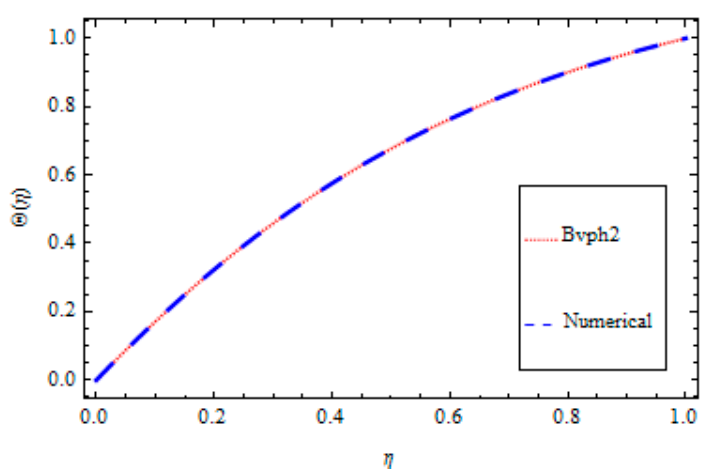
Figure 5. Graphical comparison of the HAM and numerical solution.